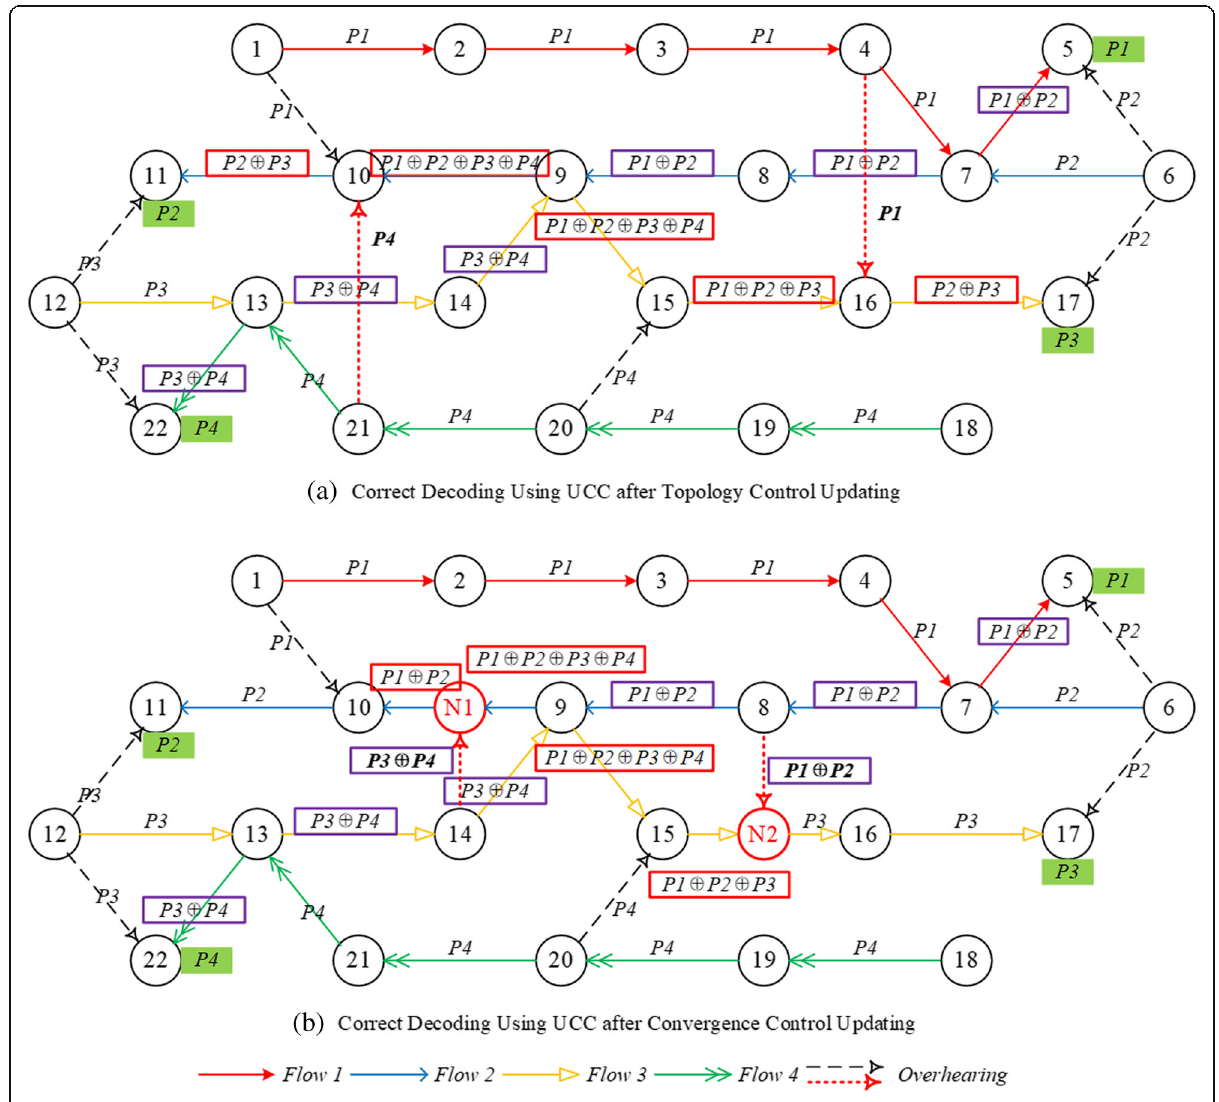
Fig. 10 Example to illustrate the benefit of cross layer network coding aware. Figure 10 illustrates two example scenarios to show the coding opportunities creating through combining routing with topology control and coverage control. a Correct decoding using UCC after topology control updating. b Correct decoding using UCC after convergence control updating